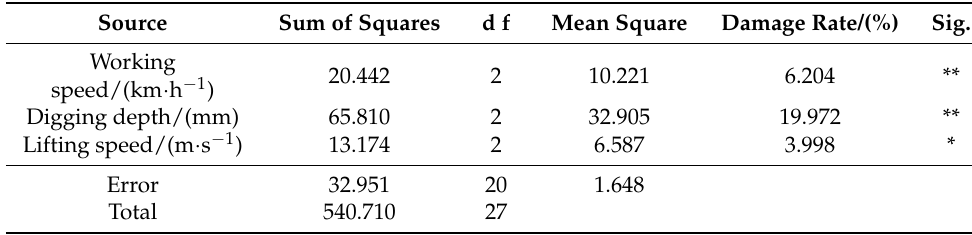
Table 5. Variance analysis of orthogonal test.